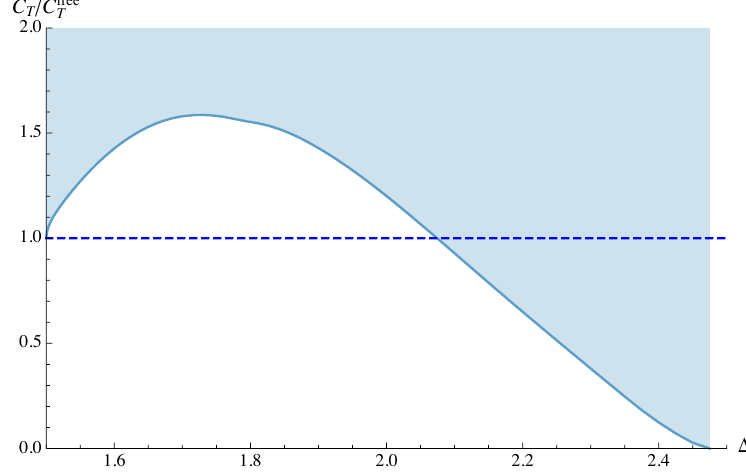
Figure 19 . Lower bound on the central charge normalized to the free fermion value C free dashed line indicates the free fermion theory. The bound has been computed at (cid:3) =